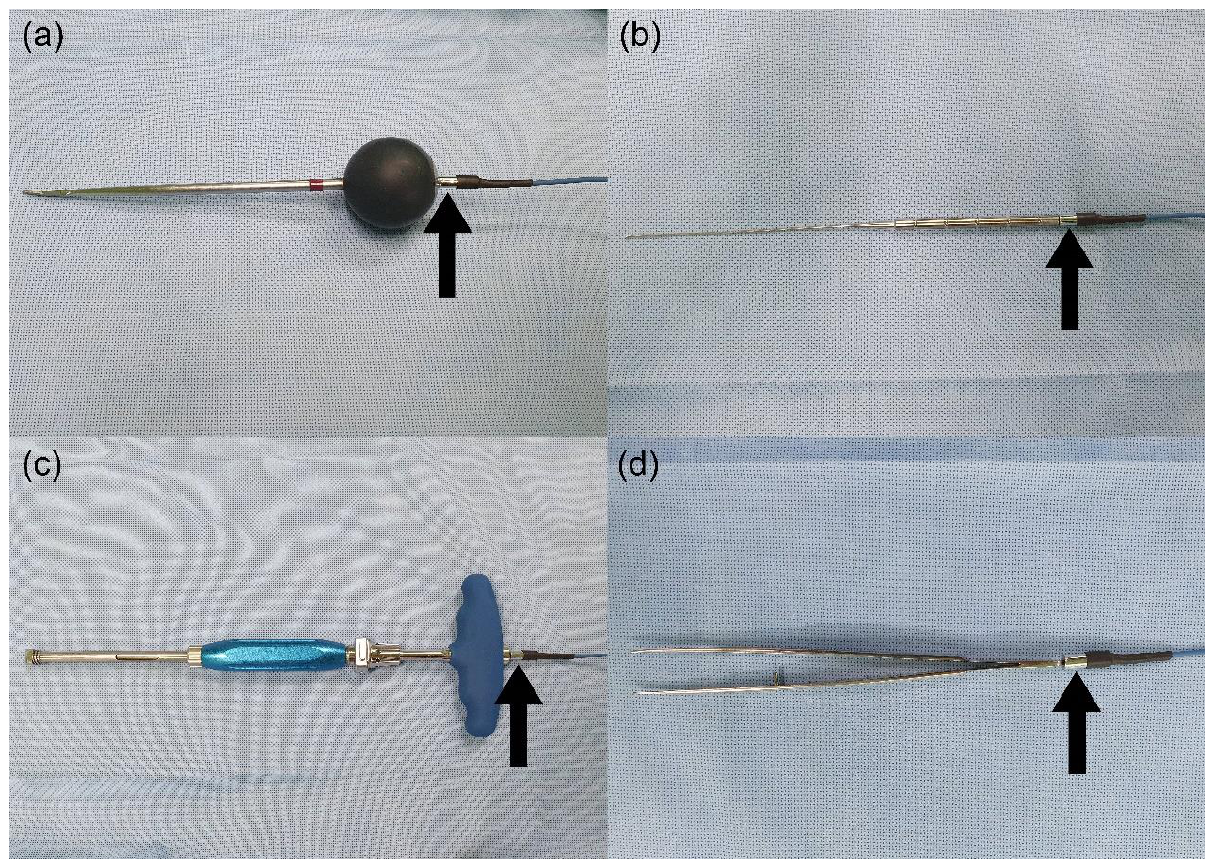
Figure 1. Magnetic nerve stimulating probe attached with various surgical instruments. The black arrow points to the magnet of the magnetic probe. ( a ) Gearshift probe. ( b ) Ball-tipped probe. ( c ) Pedicle screwdriver. ( d ) Long forcep.